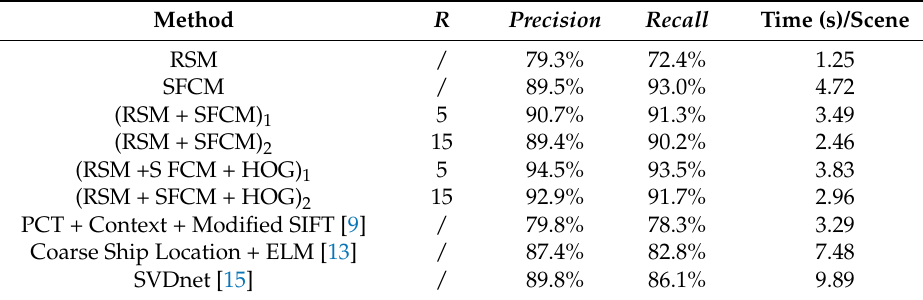
Table 5. Proposed ocean ship detection performance